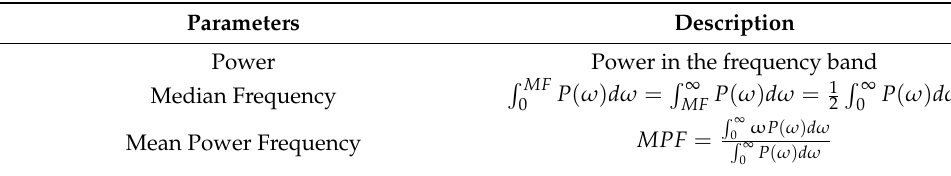
Table 4. Frequency-domain features mathematical